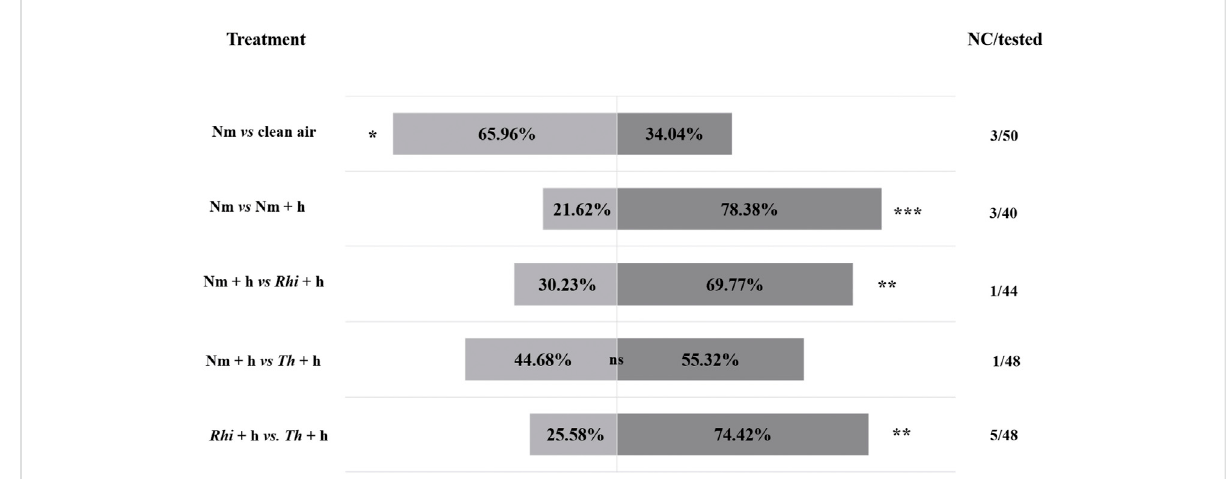
FIGURE 1 Responses of Macrolophus pygmaeus female predators to the volatiles emitted by non-inoculated (Nm), non-inoculated + S. exigua (Nm + h), Rhizophagus irregularis -inoculated + S. exigua ( Rhi + h), Trichoderma harzianum -inoculated + S. exigua ( Th + h) plants or clean air (air). At the sides of each bar, are shown the percentages of the predator females that moved towards the corresponding odor source based on the comparison indicatedontheleftsideofthebars.Thenochoice/testedcolumn ontherightofeachbarindicatesthenumberoffemalepredators thatmade no choice over the total number of tested predators (44 – 50 predators depending on the treatment combination were tested). In total, 13 out of 230 predators failed to make a choice. Asterisks indicate signi fi cant differences after performing a χ 2 test: ns ( p > 0.05), p ( p < 0.05), pp ( p < 0.01), and ppp ( p <